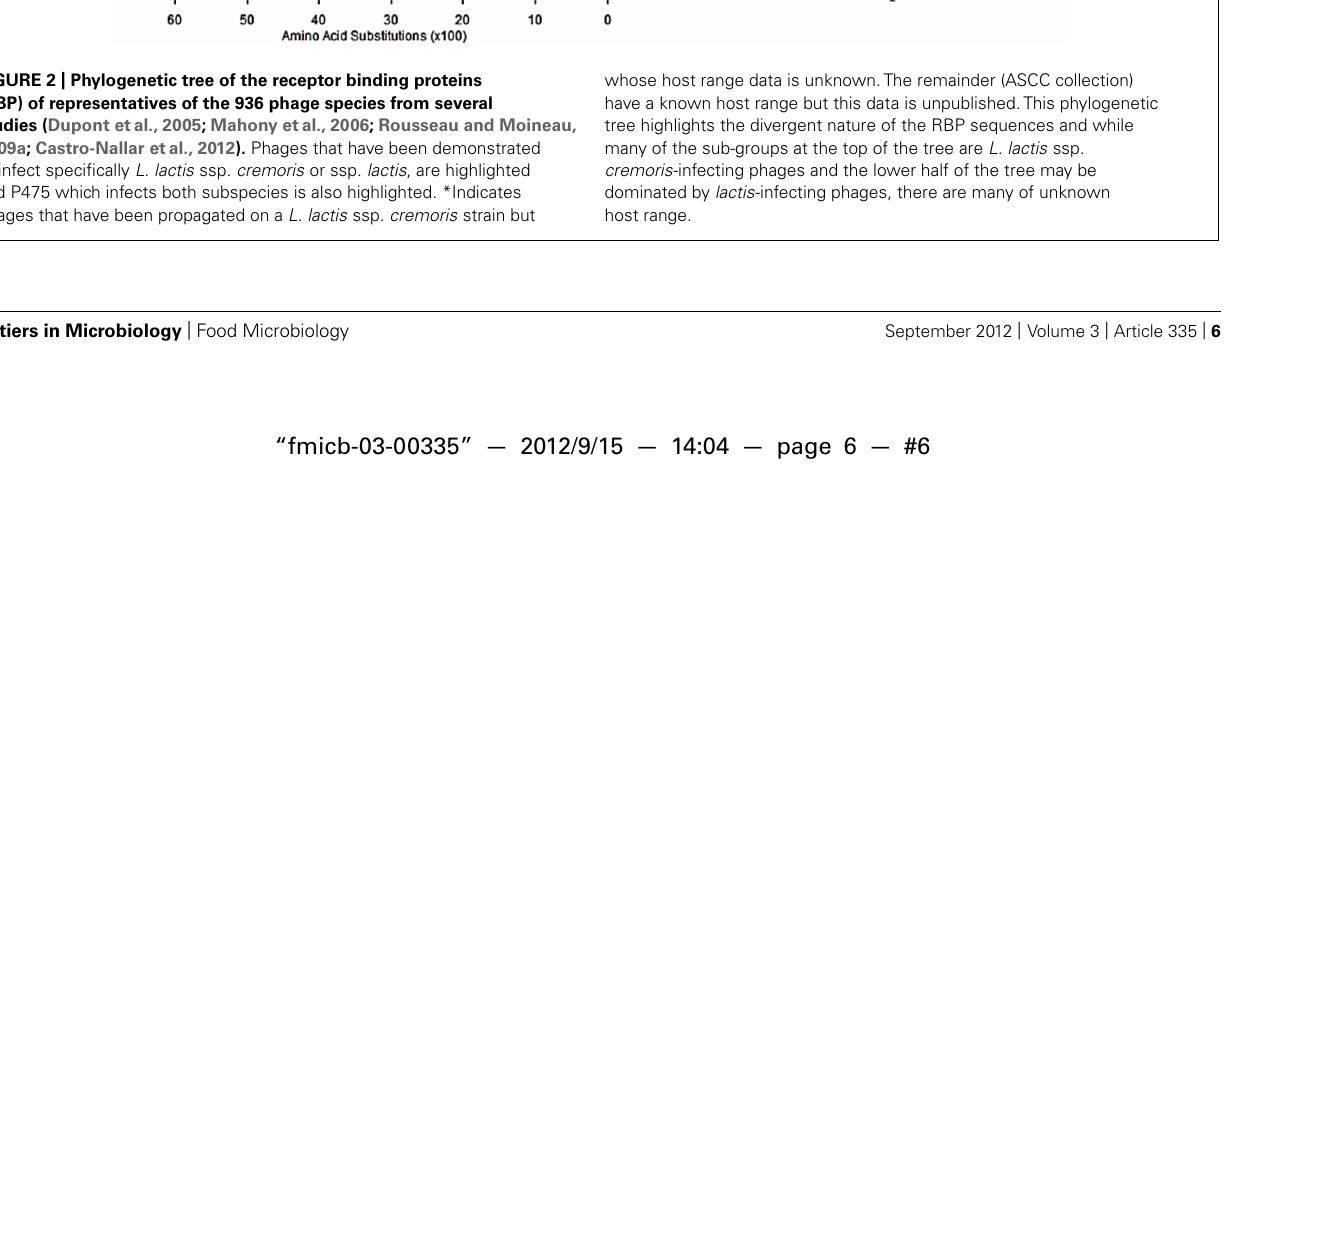
whose host range data is unknown.The remainder (ASCC collection) have a known host range but this data is unpublished.This phylogenetic tree highlights the divergent nature of the RBP sequences and while many of the sub-groups at the top of the tree are L. lactis ssp. cremoris -infecting phages and the lower half of the tree may be dominated by lactis -infecting phages, there are many of unknown host